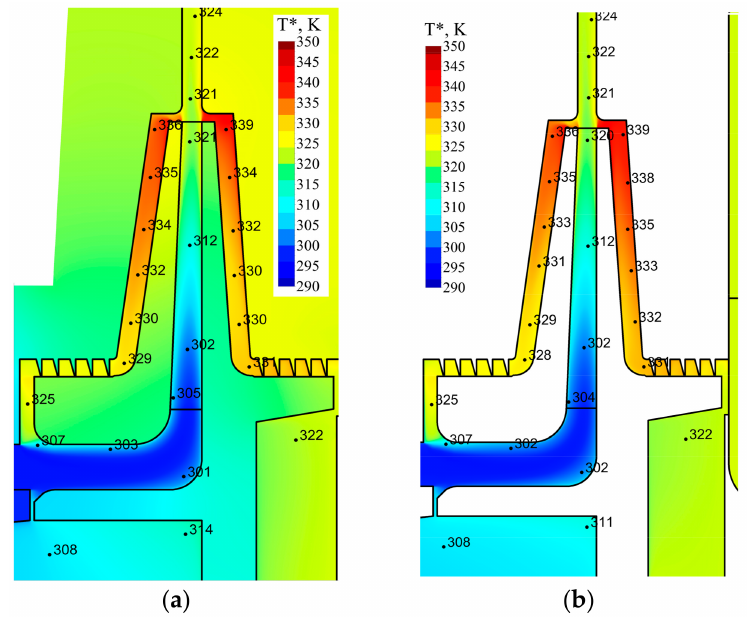
Figure 7. The comparison of temperature fields. ( a ) In the impeller with the conjugate heat exchange; ( b ) In the simplified accounting method of the heat